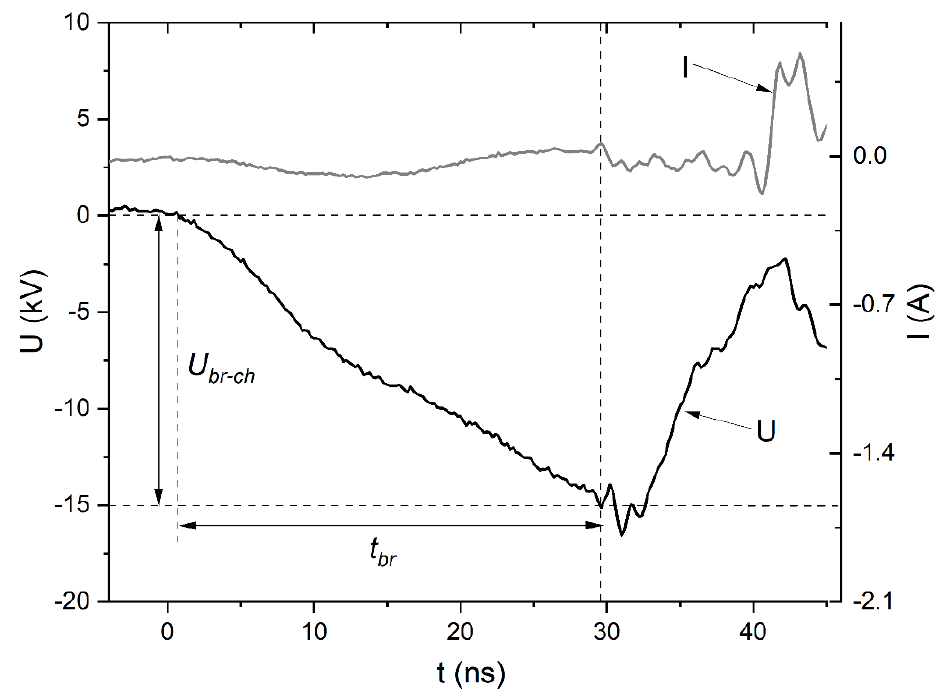
Figure 3. Voltage and current waveform for breakdown event in air (304 kPa). U br-ch and t br are shown in this figure.